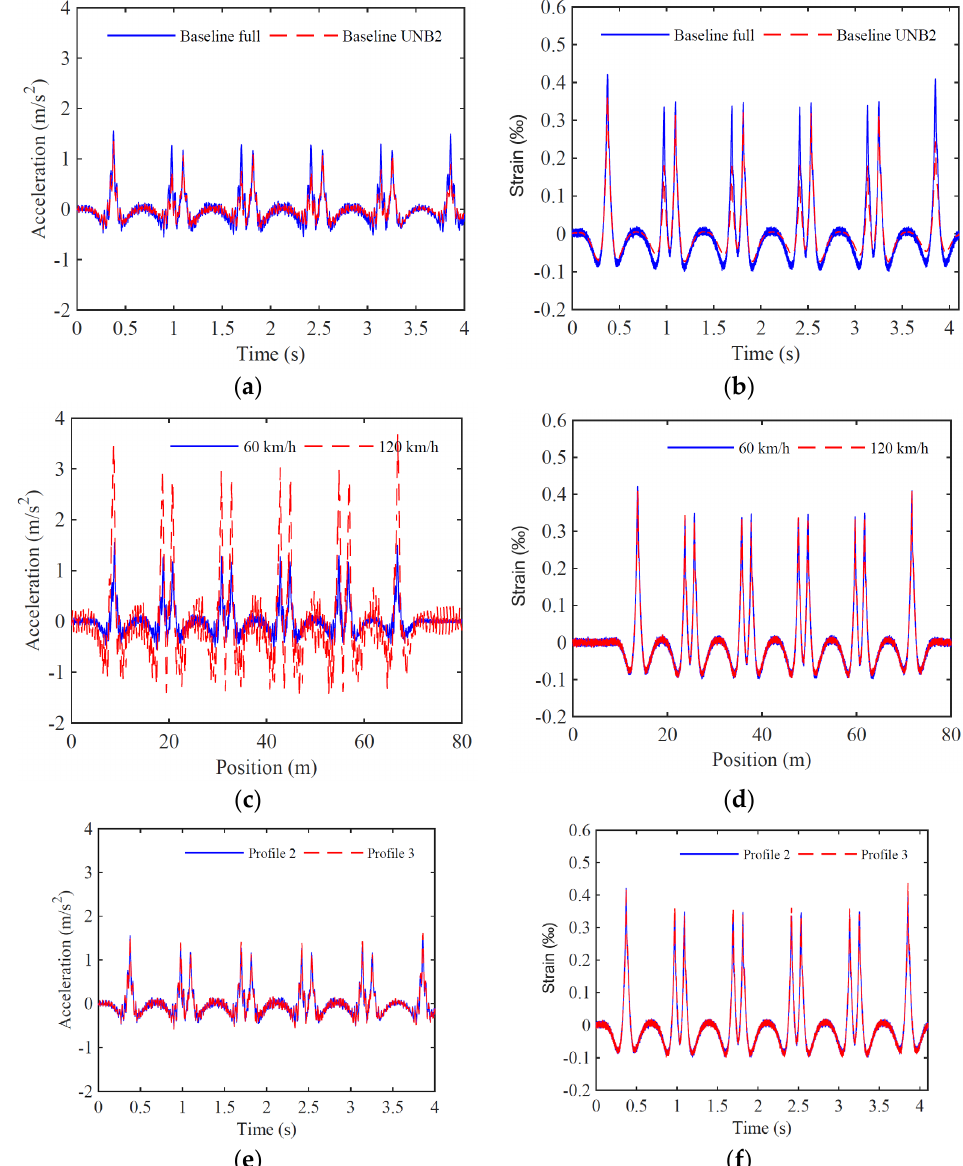
Figure 8. Time-series with accelerations ( a , c , e ) and strains ( b , d , f ) measured in position 1 for baseline scenarios: ( a , b ) comparison between full and UNB2 load schemes; ( c , d ) comparison between 60 and 120 km/h; ( e , f ) comparison between irregularities profile 2 and 3.